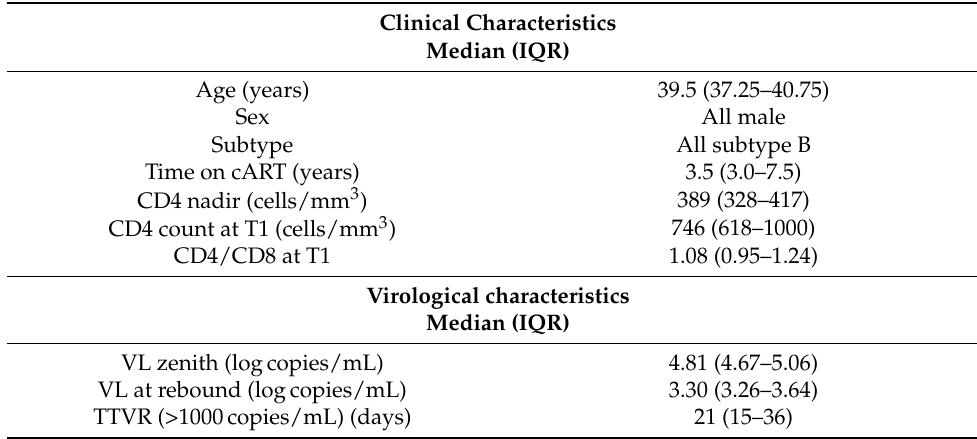
Figure 1. Overview of PBMC sampling timepoints. The clinical trial included an ART treatment interruption (ATI), which was considered day 0. PBMCs were collected prior to ATI at T1 (at undetectable VL), at T2 (7–15 days post-ATI, undetectable VL), T3 (viral rebound) and T4 (3 months after cART reinitiation). Median days for T3 and T4 are depicted, as well as the range. Table 1. Clinical and virological characteristics of participants in the HIV-STAR cohort; n = 10. Values shown are medians and the interquartile range (IQR) between brackets. VL: viral load; TTVR: Time to viral